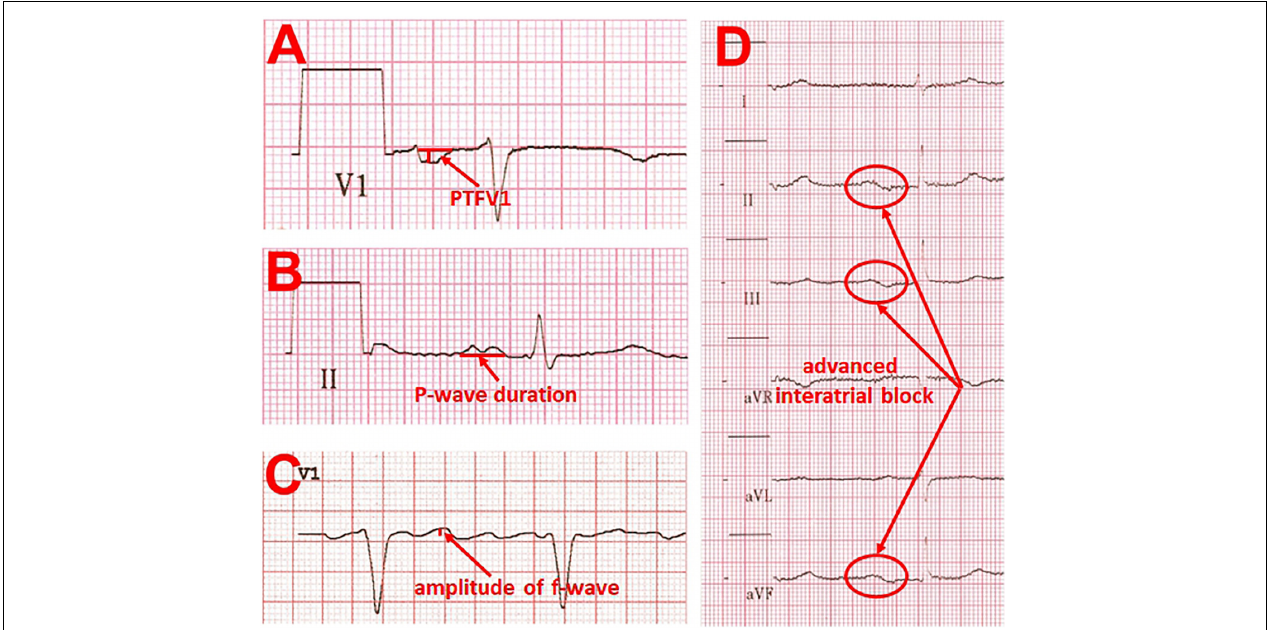
FIGURE 2 | Examples of ECG changes that are indicative of left atrial cardiomyopathy. (A) pronounced P-wave terminal force in lead V1 ≤ –4,000 µ V × ms (multiplying the amplitude of the second term of the P-wave by the width of this term). (B) Prolonged P-wave duration ( ≥ 120 ms) and double peaked morphology. (C) “Coarse” atrial fibrillation with an amplitude of > 0.1 mV. (D) Example of an advanced interatrial block, defined as P-wave duration ≥ 120 ms with simultaneous biphasic morphology in the inferior